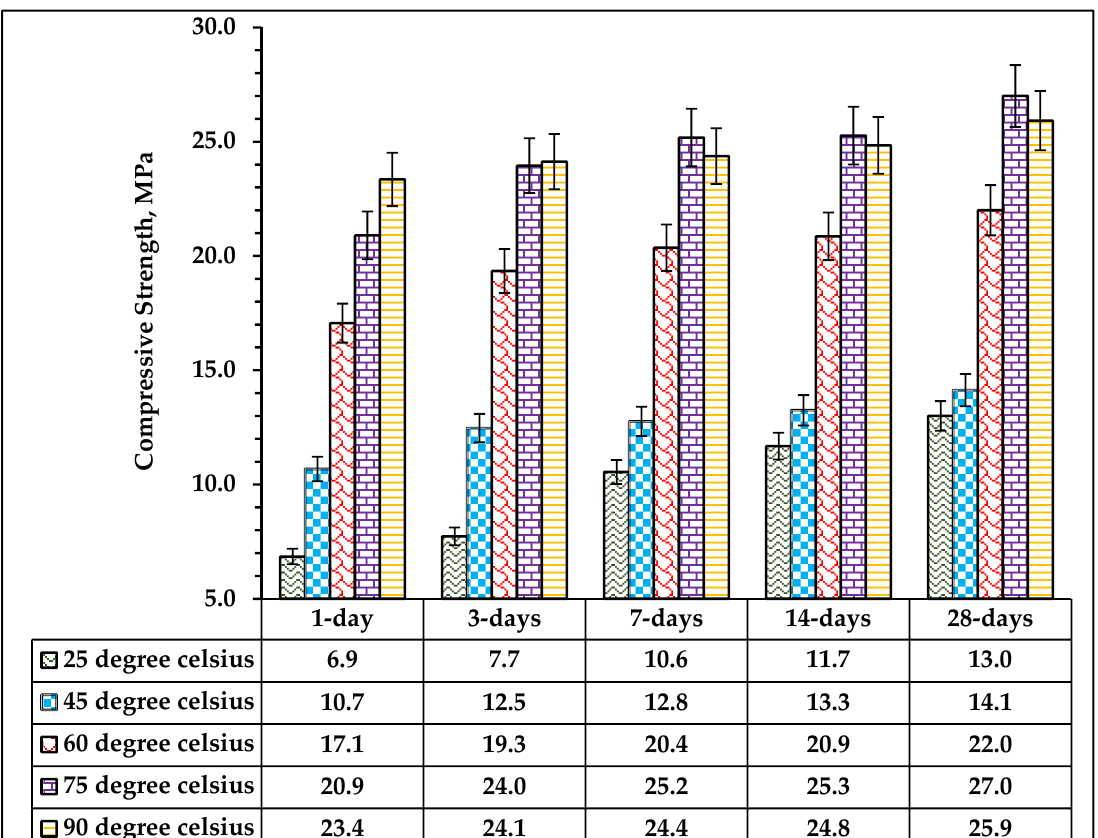
Figure 11. Effect of temperature on compressive strength of AANL mixes.